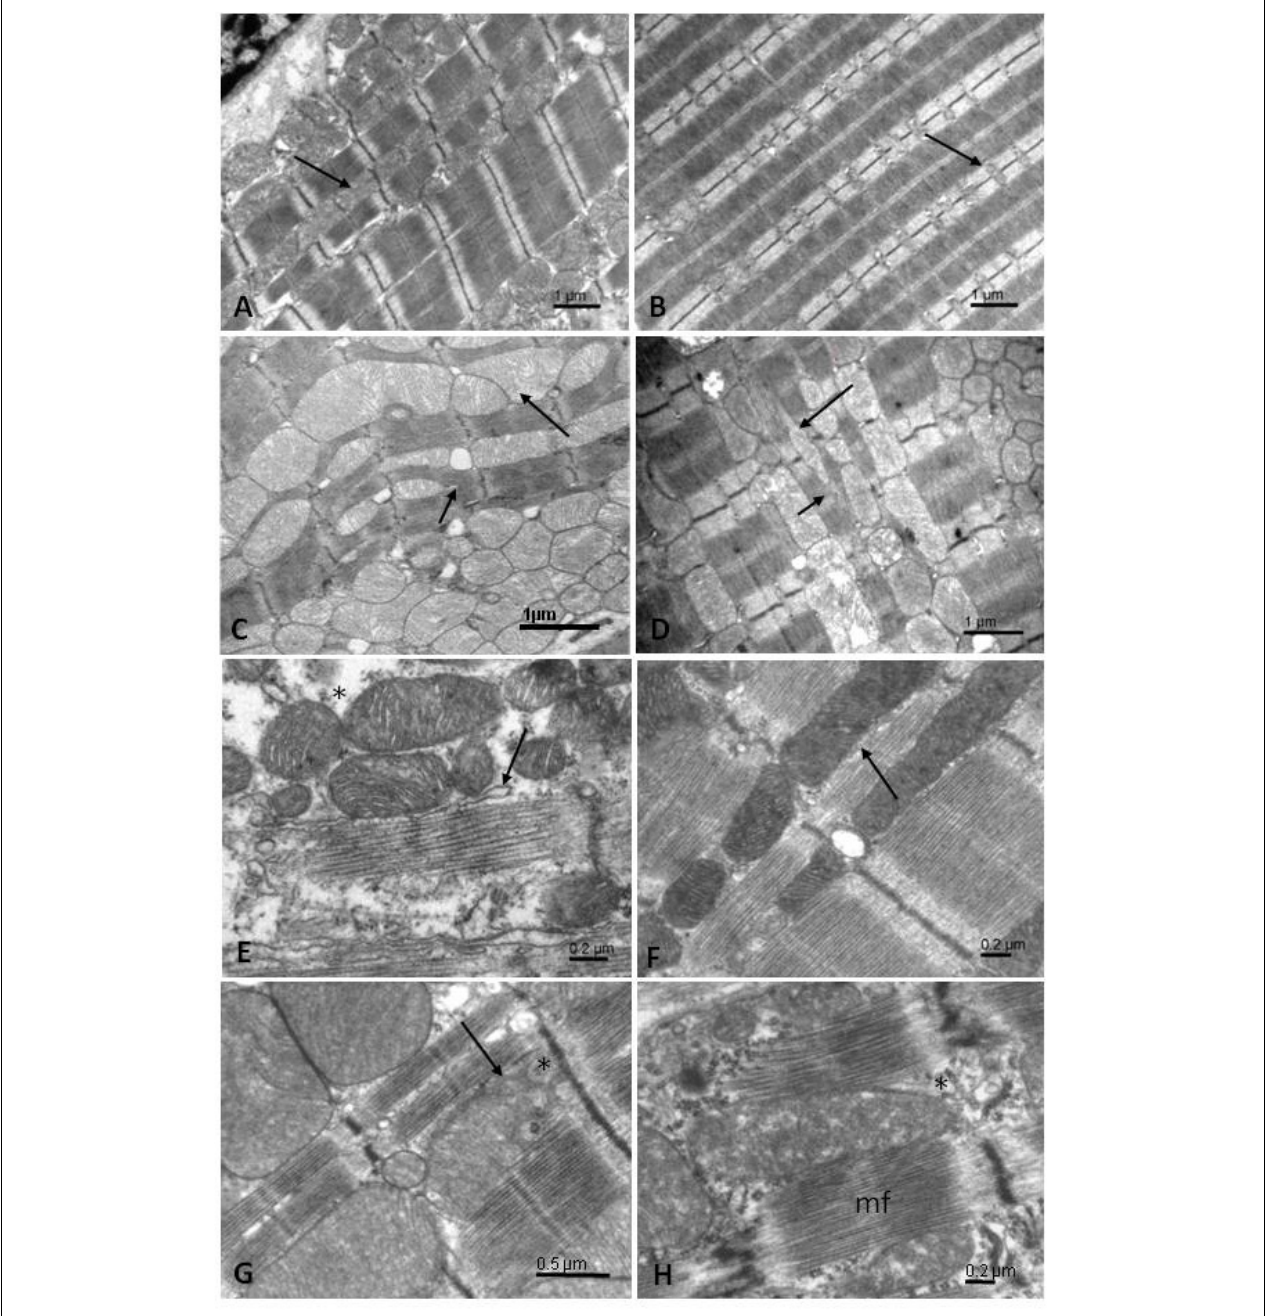
FIGURE 1 | Electron microscopic pictures of mitochondrial organization in mouse muscle cells. (A) Cardiomyocyte with regularly arranged mitochondrial rows between myofibrils. (B) Muscle fiber from white gastocnemius with small mitochondria occurring near the Z-lines. (C) Mitochondrial clusters and branching of myofibrils in CK-deficient cardiomyocyte. (D) increased mitochondrial content in CK-deficient gastrocnemius muscle. Long arrows: mitochondria; short arrows—branching of myofibrils. (E) Mitochondrial environment in 3-days old cardiomyocyte. (F) Occurrence of mitochondria in 21-days old cardiomyocyte. (G) Environment of mitochondria in control adult cardiomyocyte. (H) Mitochondrial environment in cardiomyocyte of adult failing heart. Long arrow: sarcoplasmic reticulum; ∗ cytosol; mf, myofibrils.